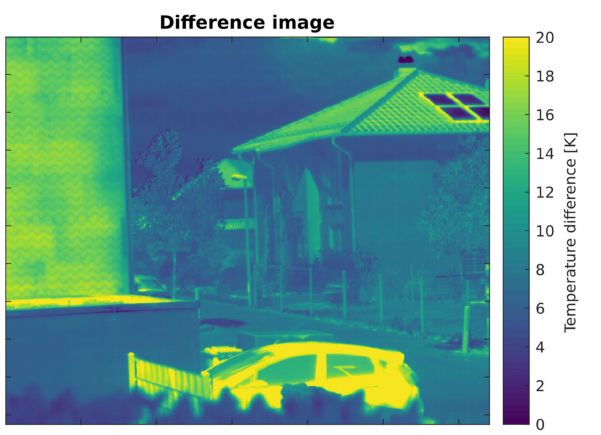
Figure 5. Difference image: last image in the heating phase subtracted by the first image